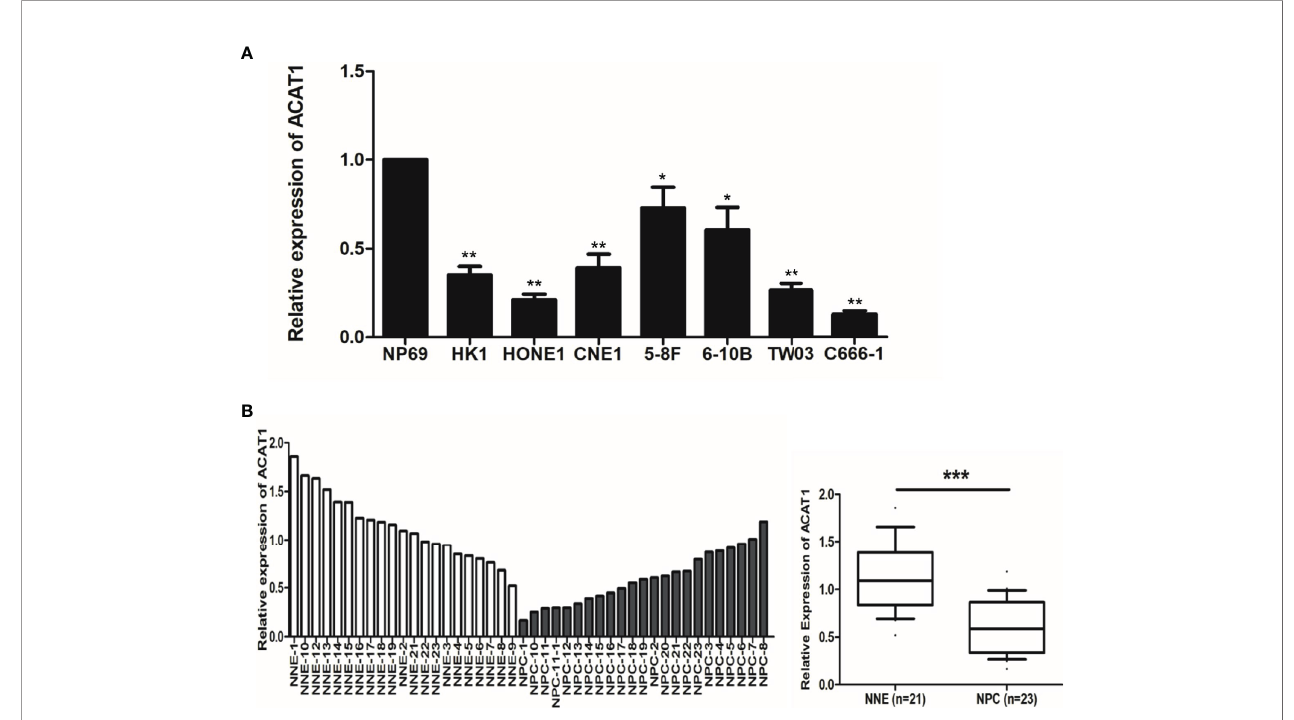
FIGURE 1 | The expression of ACAT1 is downregulated in NPC. (A) ACAT1 mRNA level was determined by real-time RT-PCR in 7 NPC cell lines and a non- cancerous nasopharyngeal epithelial (NNE) cell line NP69. The independent Student ’ s t-test was used to analyze the results and data are expressed as the means ± SD. (B) Relative ACAT1 mRNA expression in NPC primary biopsies (n=23) and NNE samples (n=21). The independent Student ’ s t-test was used to analyze the results. The line inside the boxes represents the median value. The box length indicates the interquartile range. * p < 0.05, ** p < 0.01, *** p <